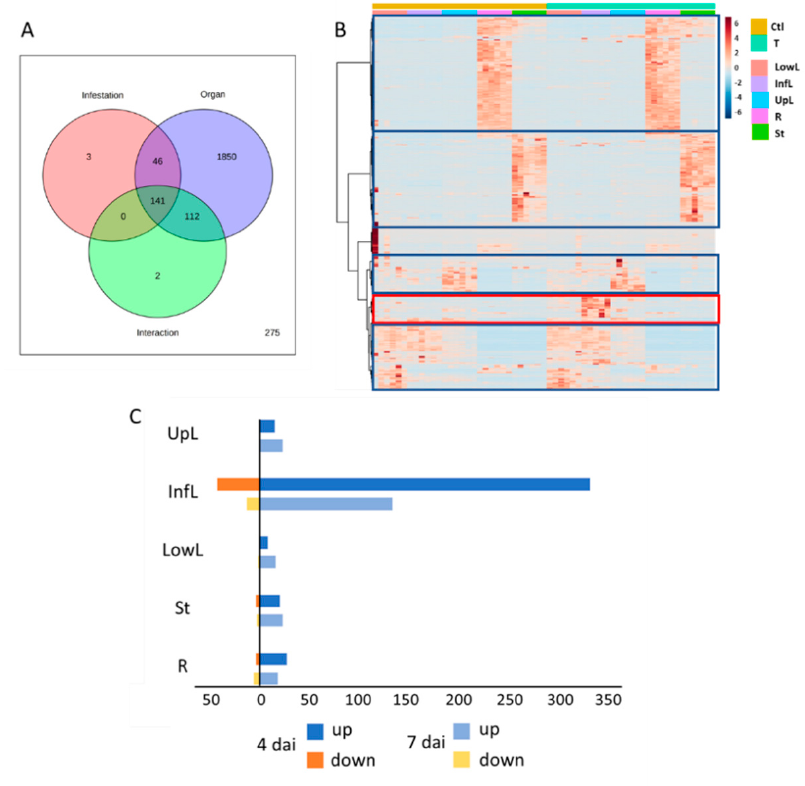
Figure 1. Impact of the T. absoluta herbivory on the metabolome of tomato vegetative organs. ( A ) Venn diagram representing the number of features significantly affected by the organ nature, T. absoluta infestation and their interaction after 4 days of herbivory, determined by a two-way ANOVA ( p < 0.05). ( B ) Heatmap plot and hierarchical clustering based on the feature intensities from the five vegetative parts of tomato plant submitted or not to T. absoluta herbivory for 4 days. Blue squares represent different clusters related to the organ nature. The red square represents the cluster of features affected by T. absoluta herbivory. ( C ) Number of differentially accumulated features per organ and per duration of herbivory by considering a log2 Fold Change > 1 and p < 0.05 (one-way ANOVA Tukey post-hoc test). The abbreviations for the organ are the following: Infested